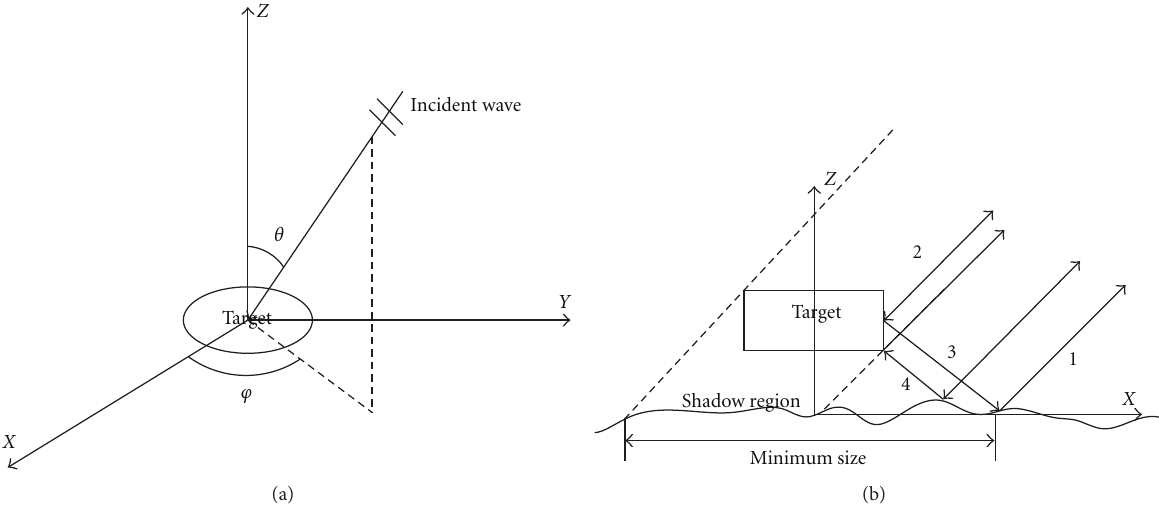
F 1: e incident parameters de�nition and the minimum size of a rough surface.